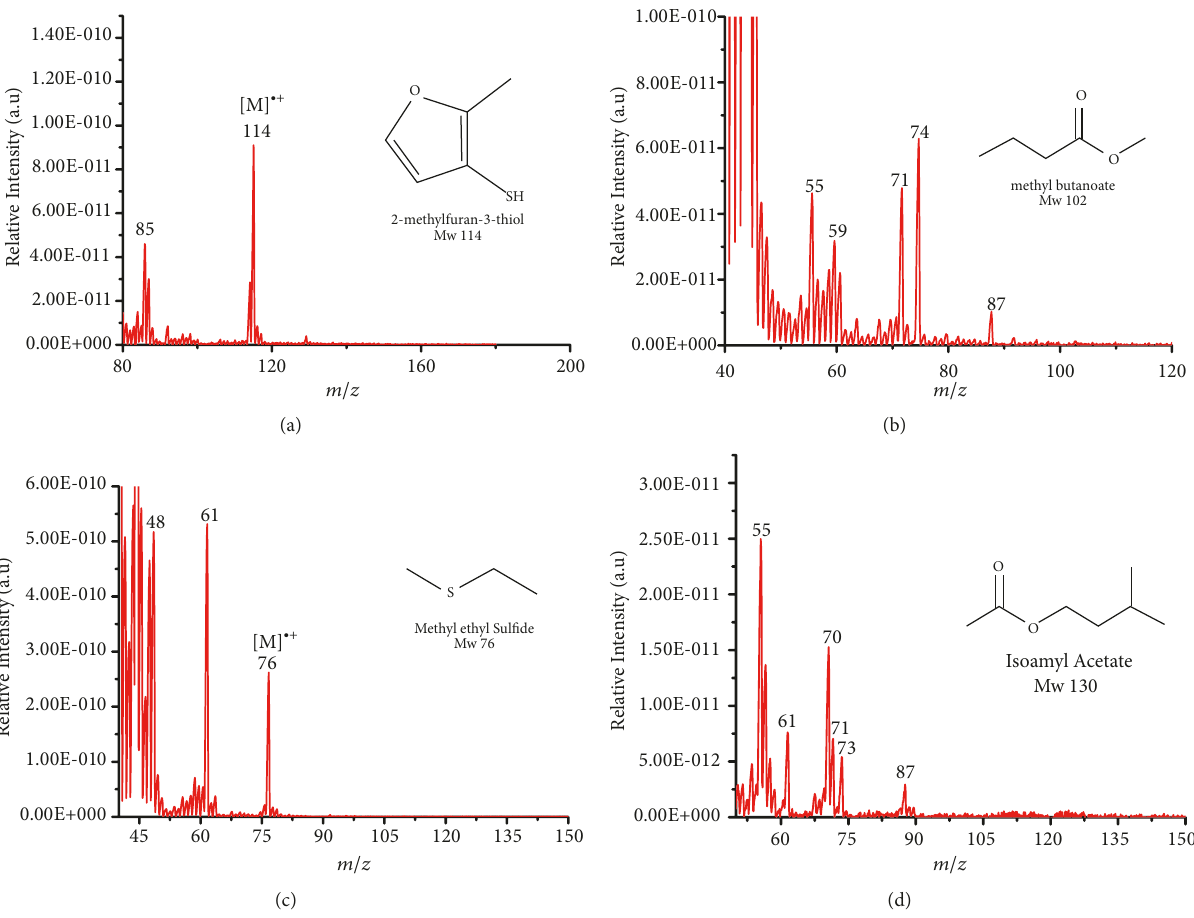
Figure 2: Representative EI mass spectra of fragrant model compounds recorded using a DIM probe combined with a portable mass spectrometer.Accurateamounts of analyte were pitted into a flask and introduced into the manifold of the portable MS througha DIM probe, 5 𝜇 L, viz 10 ppb. (a) 2-methylfuran-3-thiol (Mw 114), (b) methyl butanoate (Mw 102), (c) ethyl methyl sulfide (Mw 76), and (d) 3-methylbutyl acetate (Mw